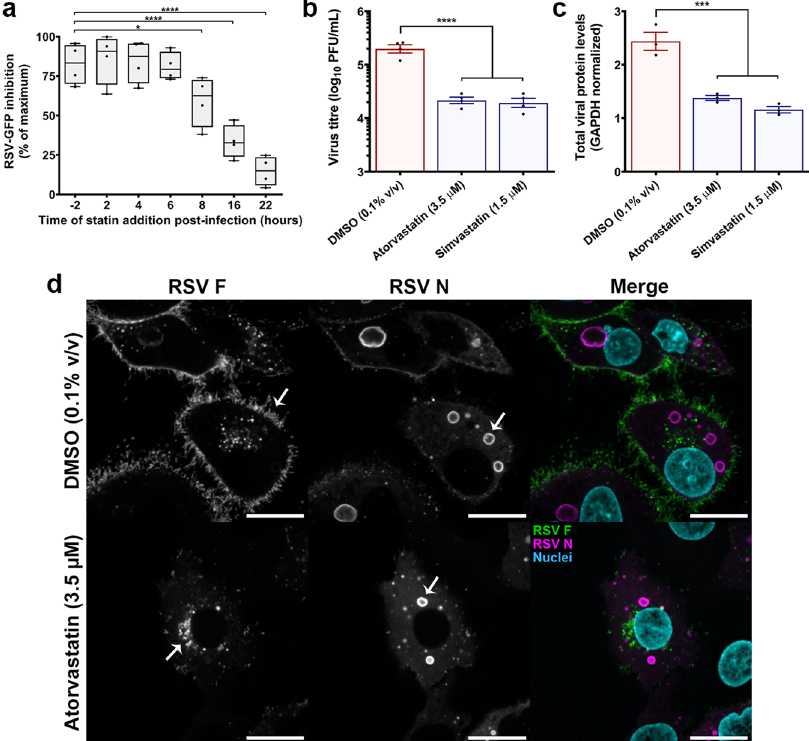
Fig. 3 Statins inhibit the production of infectious virus. a The actions of statins on the replicative cycle of RSV were probed by a time-of-drug addition assay. Atorvastatin (3.5 µ M) was added to RSV-GFP-infected HEp-2 cells (MOI 2.0) at discrete timepoints pre- or post-infection, and infection rate was quanti fi ed 24 h p.i. No difference in antiviral effect was observed between 2-h pre-treatment and 2- to 6-h post-treatment, indicating cell entry was unaffected by statins. A loss in antiviral effect occurred when statins were added 8 – 22 h p.i., consistent with inhibition of post-entry events. Box plots indicate the complete range (whiskers), interquartile range (box), and median (line) of measurements. The y -axis denotes atorvastatin inhibition of RSV- GFP normalized to its maximum effect (i.e., % of maximum statin inhibition) ( n = 4 independent measurements). b Infectious virus production was quanti fi ed by plaque assay from the supernatants of RSV A2-infected HEp-2 cells + / − atorvastatin (3.5 µ M) or simvastatin (1.5 µ M). Statin treatment caused a signi fi cant decrease in the production of infectious progeny virions. Values are reported as means ± SEM ( n = 4 independent measurements). c Western blot analysis of lysates collected from RSV A2-infected HEp-2 cells (MOI 0.5) + / − atorvastatin (3.5 µ M) or simvastatin (1.5 µ M) 24 h p.i. Statin treatment caused a decrease in total viral protein levels. Blots were stained using a pan-RSV polyclonal antibody (B65860G) that detects all viral antigens (see Supplementary Fig. 2). GAPDH controls were processed on a parallel blot with the same samples and protein load. Values are reported as means ± SEM ( n = 3 cell lysates). d High-resolution confocal microscopy of the F (green) and N (magenta) proteins in RSV A2-infected HEp-2 cells (MOI 0.5). Atorvastatin treatment decreases F surface expression, and N is localized to cytoplasmic inclusions (as indicated by the arrows). Scale bars = 20 µ